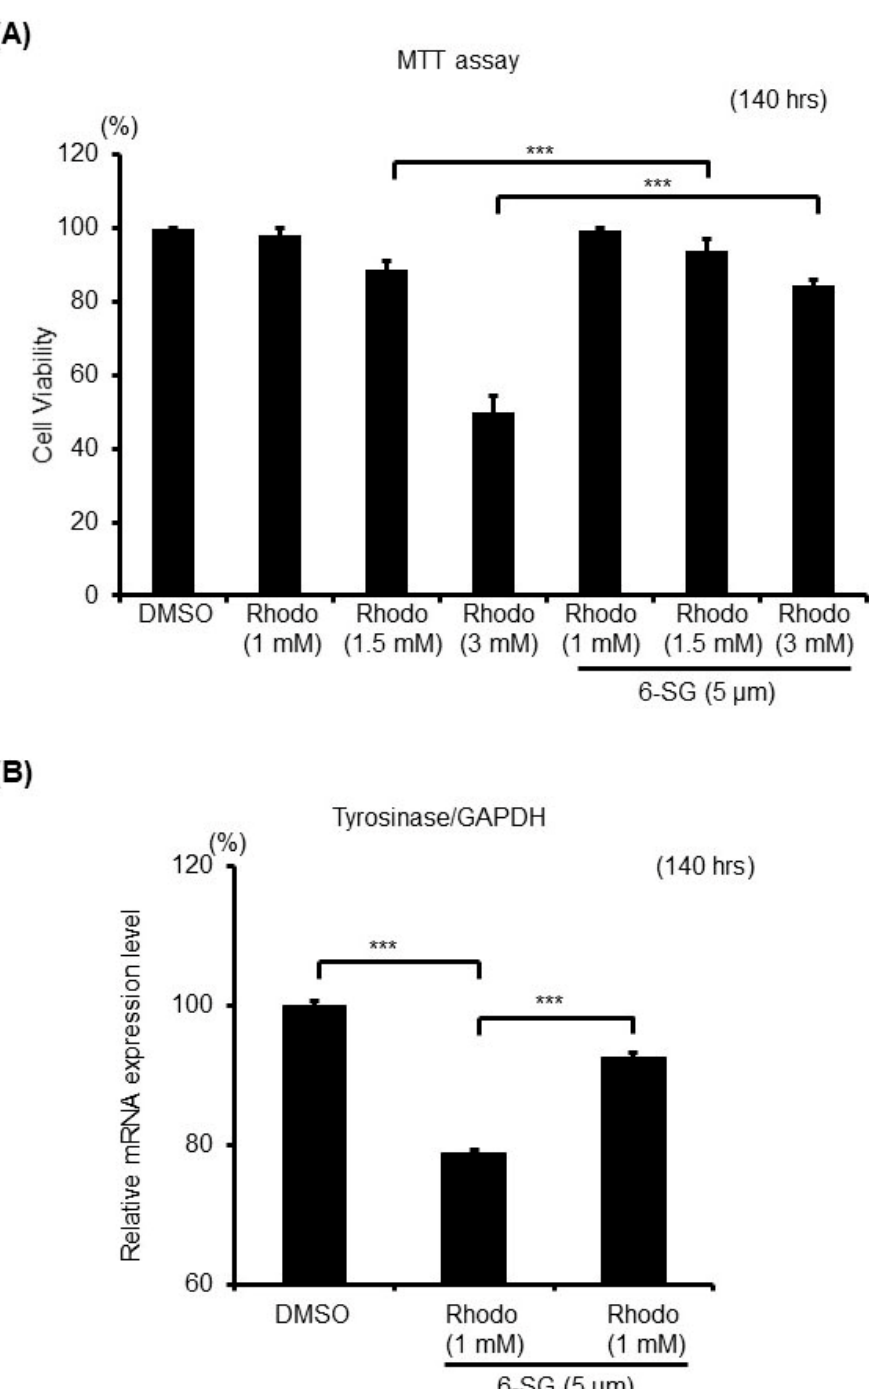
Figure 5. Cell viability and melanogenesis-related gene expression in cultured human epidermal melanocytes after exposure to the indicated treatment with 6-SG for 140 h. ( A ) Cell viability assessment by MTT assay; ( B ) Tyrosinase mRNA expression level analyses using real-time PCR. Data in ( A ) and ( B ) represent the results of three independent experiments. Data are shown as mean ± SD. ***, p < 0.01. Data in ( B ) are normalized to GAPDH.